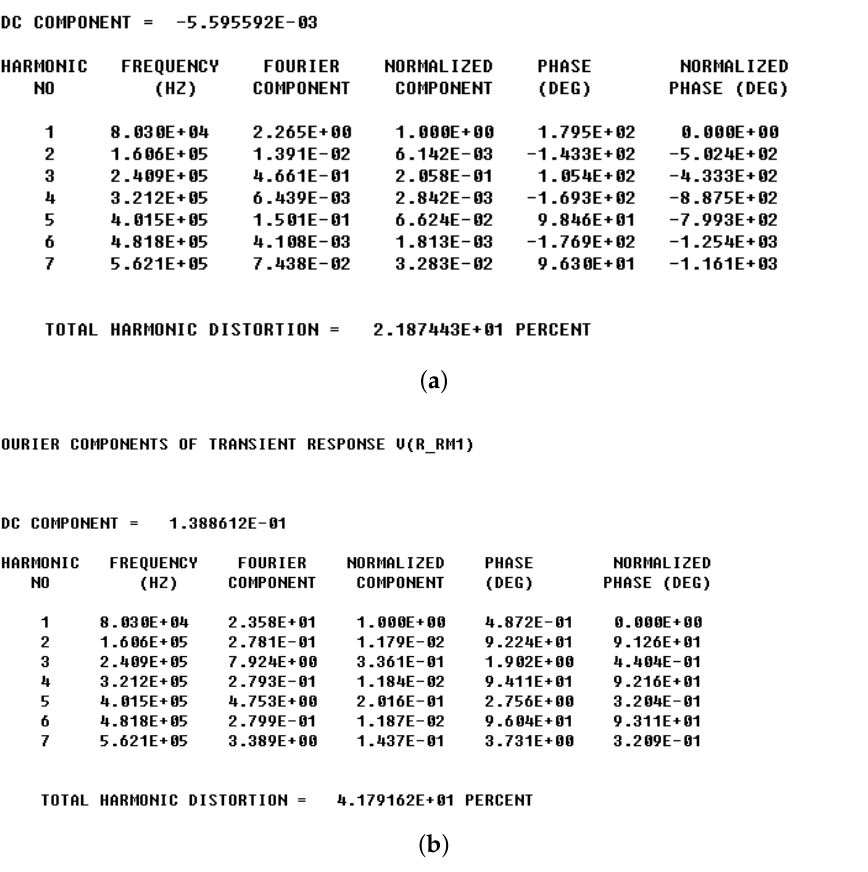
Figure 7. Analysis result represented as the list form. ( a ) List of the FFT analysis result for the output voltage; ( b ) list of the FFT analysis result for the output current.